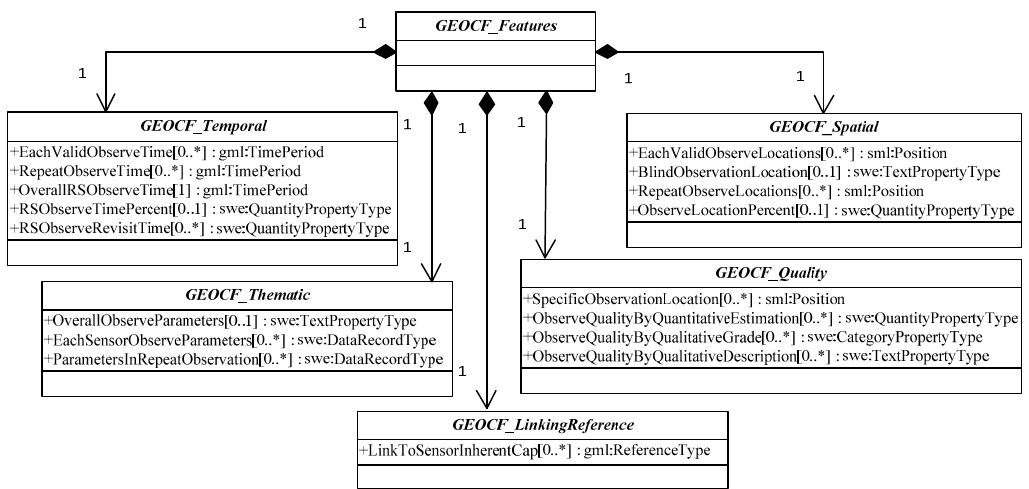
Figure 4. UML diagram of GEOCF feature components and their data types.